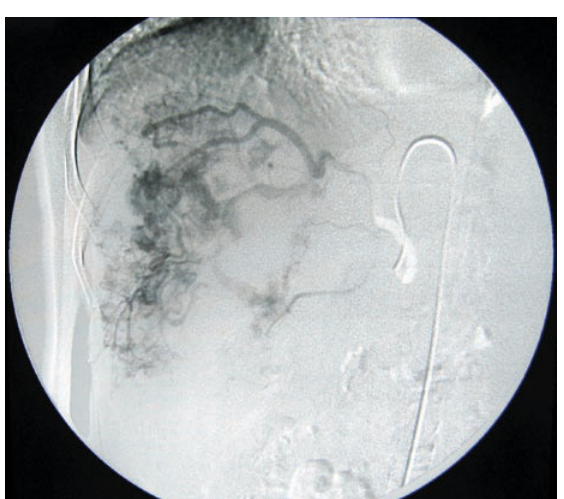
Figure 5. Hepatic angiogram.